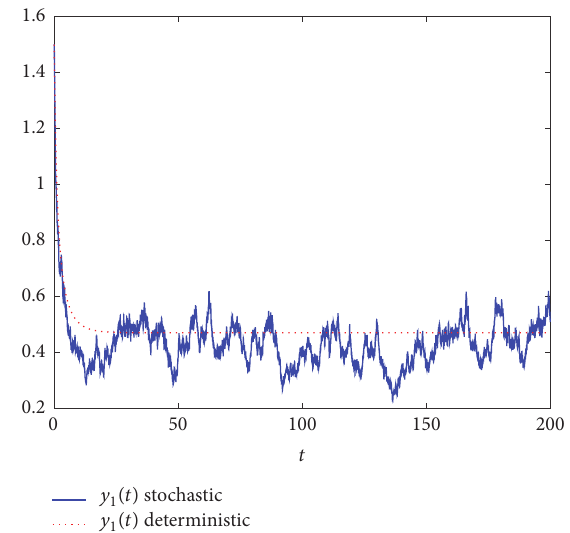
Figure 1: Solution of model (62) for 𝛾 1 (𝜃) = (1.5,1.3, 1) . Blue: 𝜎 𝑖 = = 0 (𝑖 = 1, 2, 3, 4, 5) 0.1 (𝑖 = 1, 2, 3, 4, 5) . Red: 𝜎 𝑖